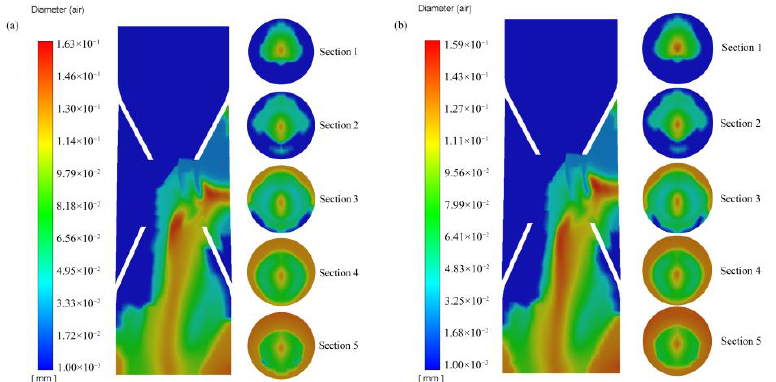
Figure 6. Program of the bubble diameter distribution at ( a ) inlet flow velocity 6.5 m/s and ( b ) inlet flow velocity 7.5 m/s.